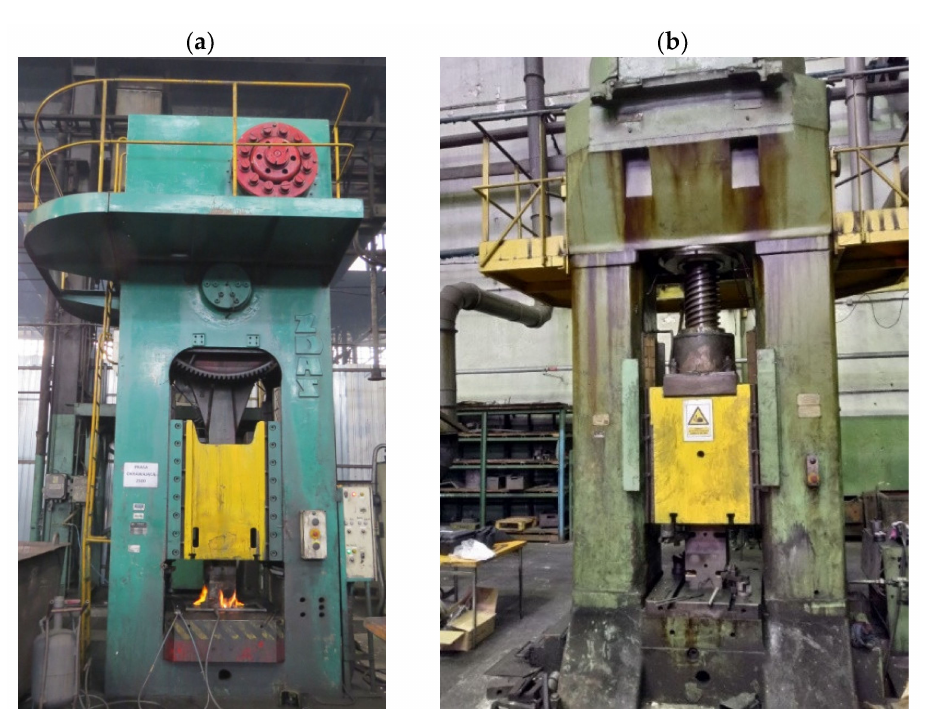
Figure 10. Pictures of forging presses used for tests in industrial conditions: ( a ) ZDAS LU 400/1000 crank press; ( b ) F1736A screw press.